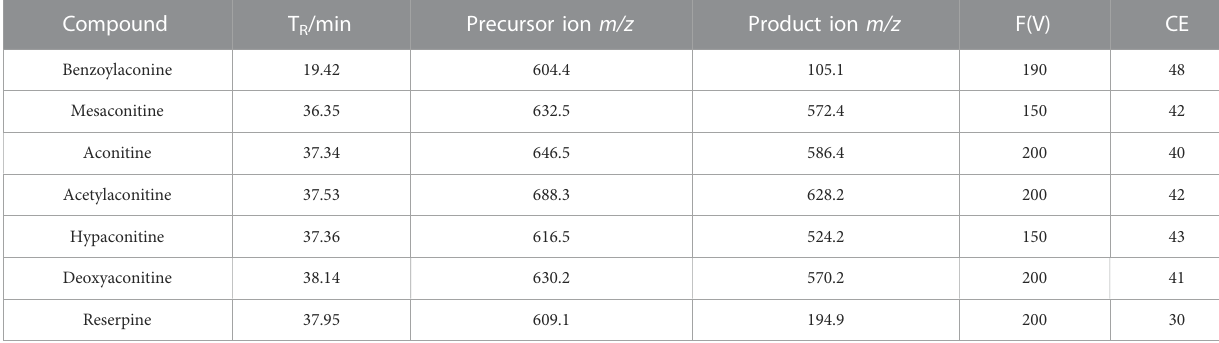
TABLE 1 Mass spectrum parameter information of each reference substance. Compound T R /min Precursor ion